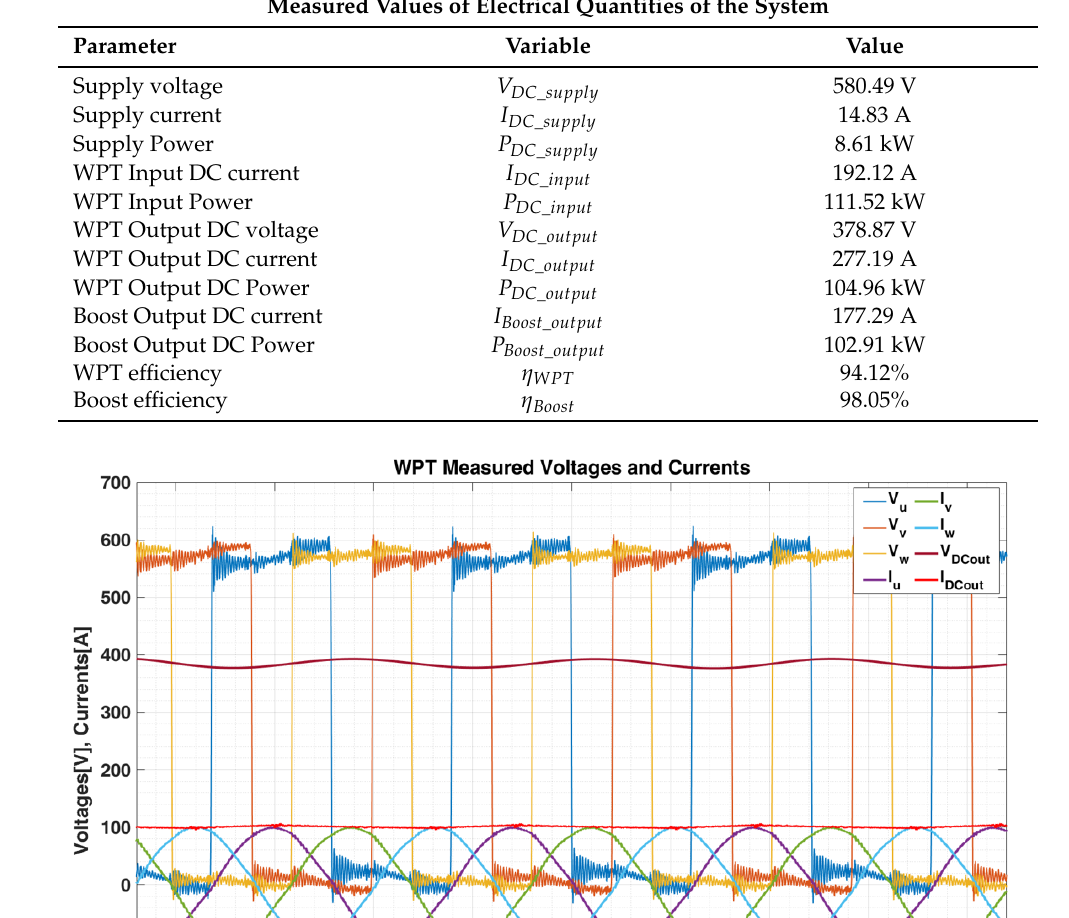
Table 4. Experimental Results of the Three-Phase WPT system.